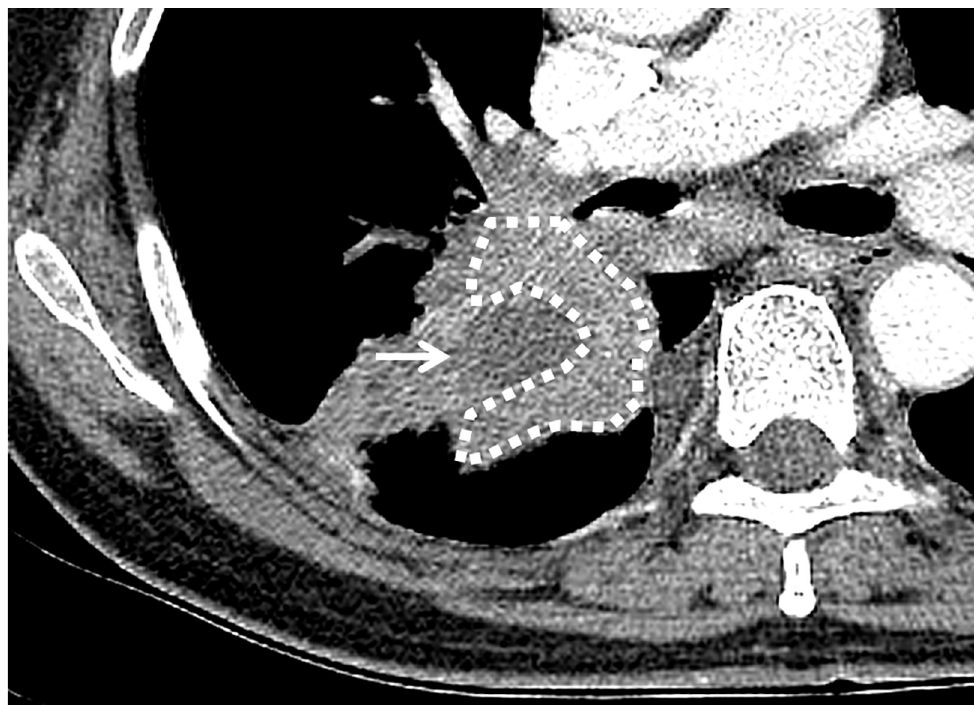
Fig 3. Placement of ROIs within the tumor. Regions of interest were drawn on the outline of the enhancing portion of the tumor (Polygon with a dashed margin). Areas showing necrosis (arrow) or cavitation were excluded from the ROI. ‘Heterogeneity’ was the standard deviation of CT values of the tumor, and ‘enhancement ratio’ was the mean CT value divided by that of the pectoralis muscle.